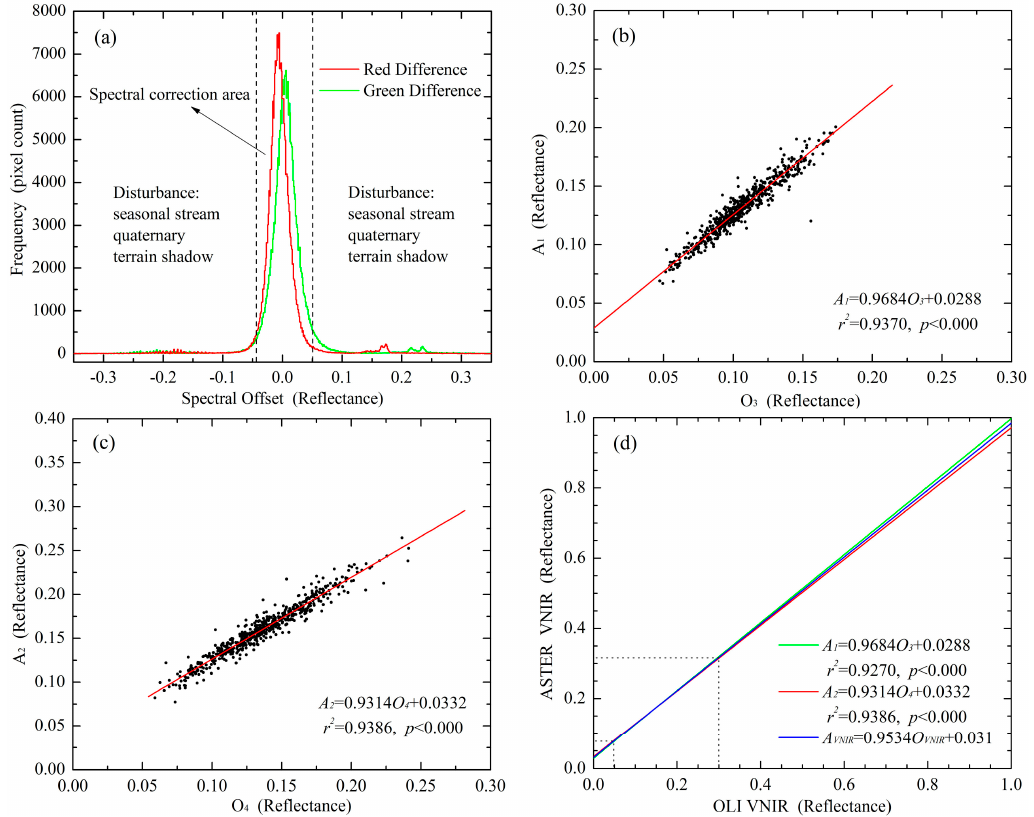
Figure 3. The histogram of spectral offset values between O3 and A1, O4 and A2 ( a ); ( b ) Two-dimensional scatterplot and linear fitting of O3 and A1 (Skipping 200 pixels to display); ( c ) Two-dimensional scatterplot and linear fitting of O4 and A2 (Skipping 200 pixels to display); ( d ) Mean linear fitting in OLI VNIR bands and ASTER VNIR